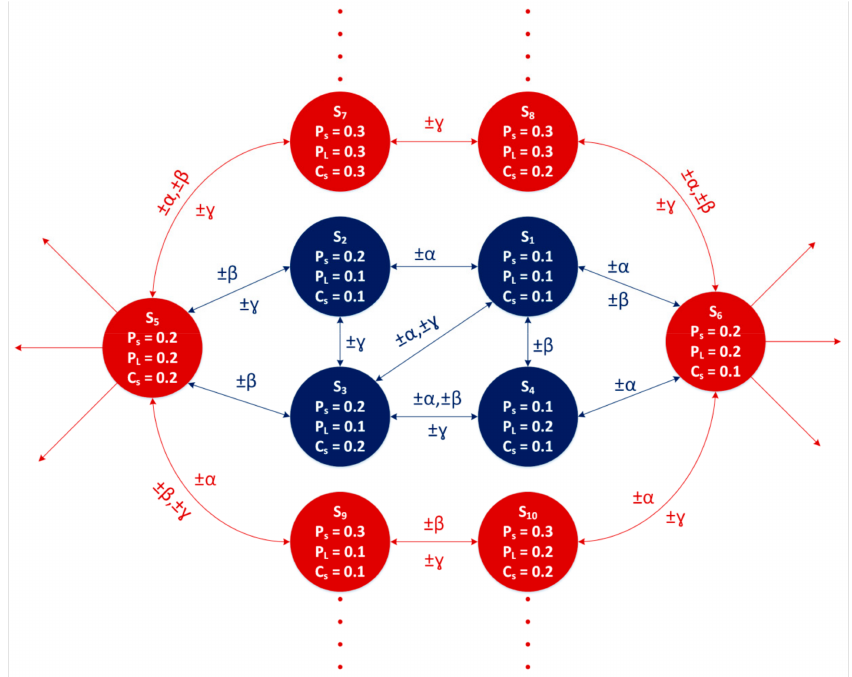
Figure 9. Conceptual state flow diagram (only three states